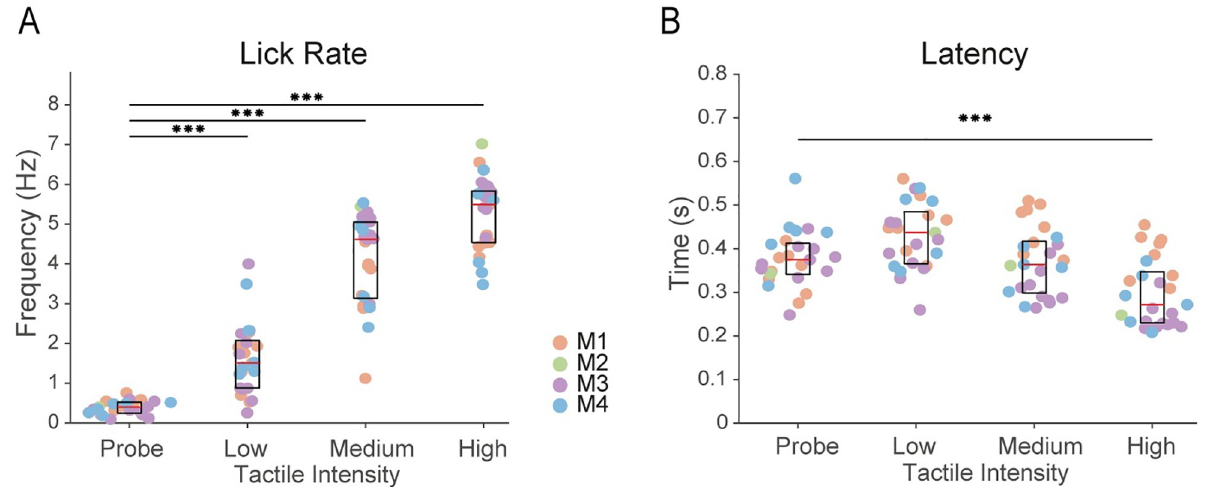
Fig 5. Lick quantification. (A-B) Lick rate (A) and latency (B) from all sessions across conditions. Significant differences between lick rates were found between the null condition and all other tactile intensities ( *** One-way ANOVA, F (3, 96) = [171.4], P = 2.04 x 10 − 38 , Bonferroni post hoc test: probe vs. low intensity, P = 1.09 x 10 − 5 ; probe vs. medium intensity: P = 4.35 x 10 − 27 , probe vs. high intensity, P = 1.81 x 10 − 35 ). The average latencies were significantly different between probe trials and the strongest intensity ( *** One-way ANOVA, F (3,96) = [13.55], P < 1 . 92 x 10 −7 , Bonferroni post hoc test, P = 0 . 0019 ). In all panels: Box plots show the median value with a red horizontal line; horizontal black lines indicate the 75 and 25 quartiles.